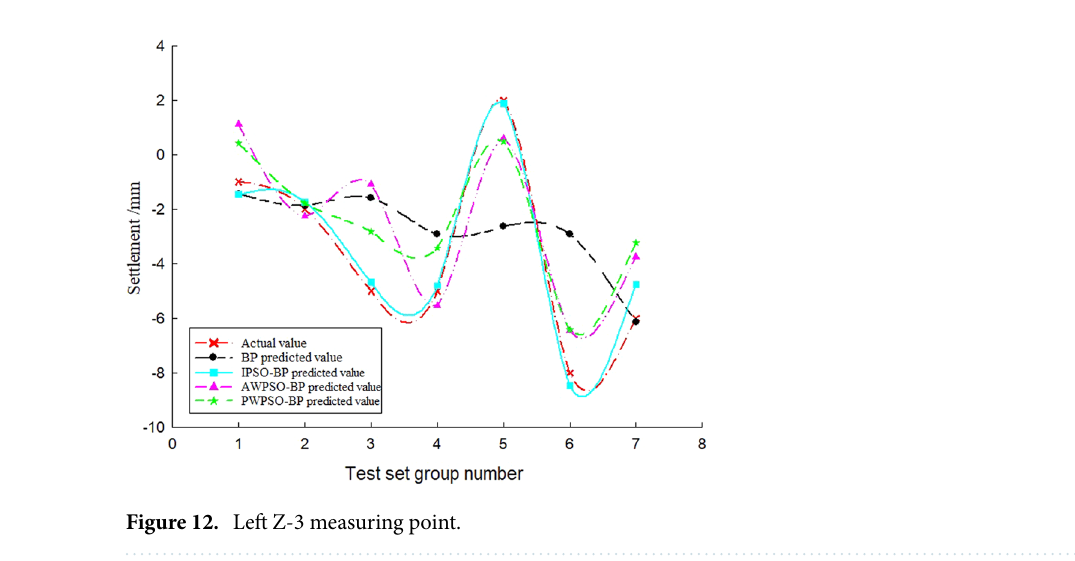
Figure 11. Left Z-2 measuring point.